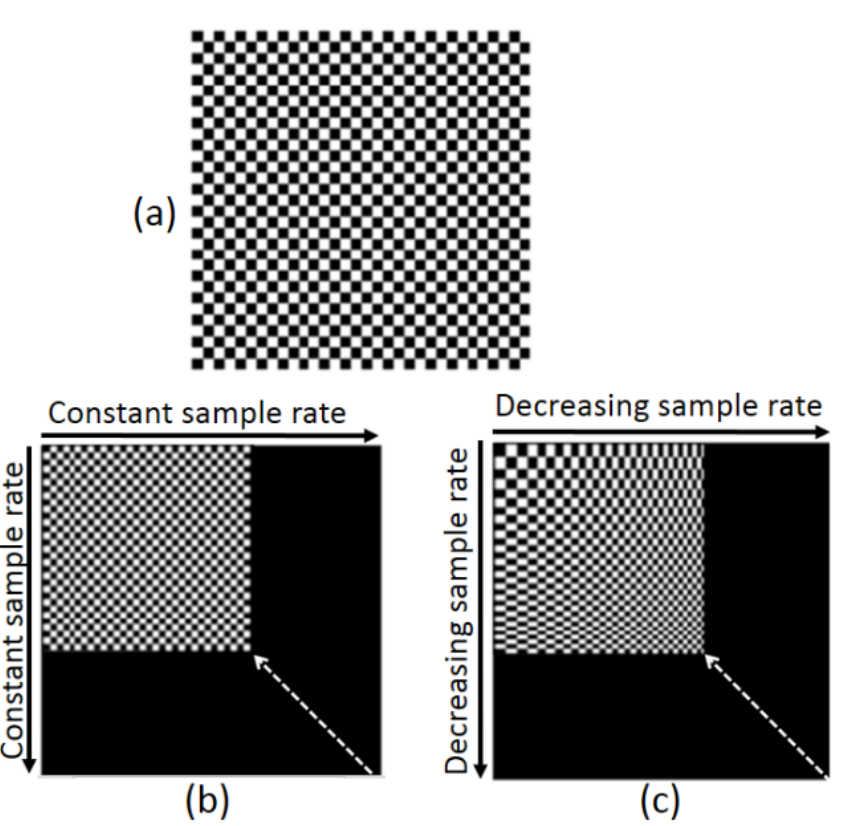
Figure 5. ( a ) Block to be downsampled; ( b ) nonelastic downsampling; ( c ) elastic downsampling. Given a vector of S values assigned to each corner, the equations to perform the Elastic Downsampling must consider an arithmetic series (Figure 6), which summation must match the entire edge of the block. In (Figure 6), S 1 and S 2 are the sample rates at block corners, and α is the sampling rate gradient.